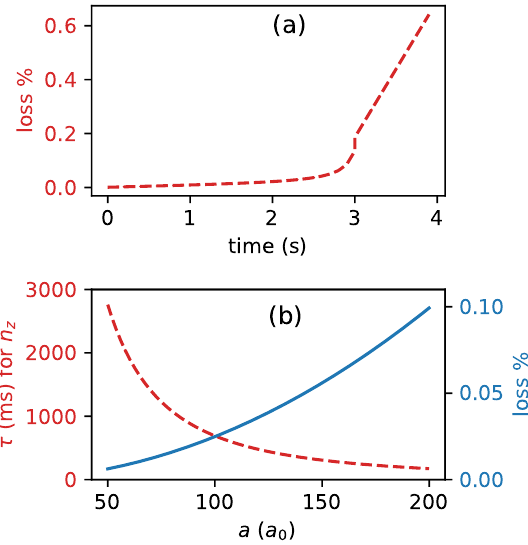
Figure 5. Three-body loss during thermalization. ( a ) The red dashed line shows the percentage of times the trapped atom will be lost due to three-body collisions during the evaporative cooling shown in Figure 4. ( b ) Effect of change in scattering length on (i) thermalization time (red dashed) and (ii) the percentage of times the single atom will be lost due to a three-body collision during one thermalization period (blue solid). Here, T B = 1 µ k and n B = 10 × 10 12 cm − 3 for ( b